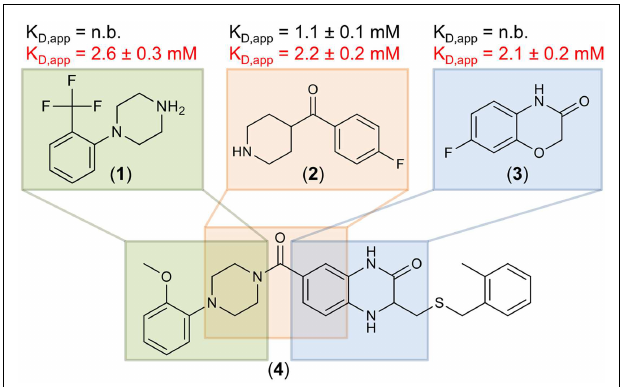
FIGURE 4 |Three fragment hits against DC-SIGN . Fragments 1, 2, and 3 were identified during the primary 19 F NMR screening and later confirmed in an SPR follow-up assay.These fragments are similar to substructures of a previously published micromolar DC-SIGN inhibitor 4 (41). Affinities measured in the presence of EDTA and Ca 2 + are highlighted in black and red, respectively. No binding (n.b.) was detected in presence of EDTA for fragments 1 and 3. SPR measurements were run in triplicates for each condition.